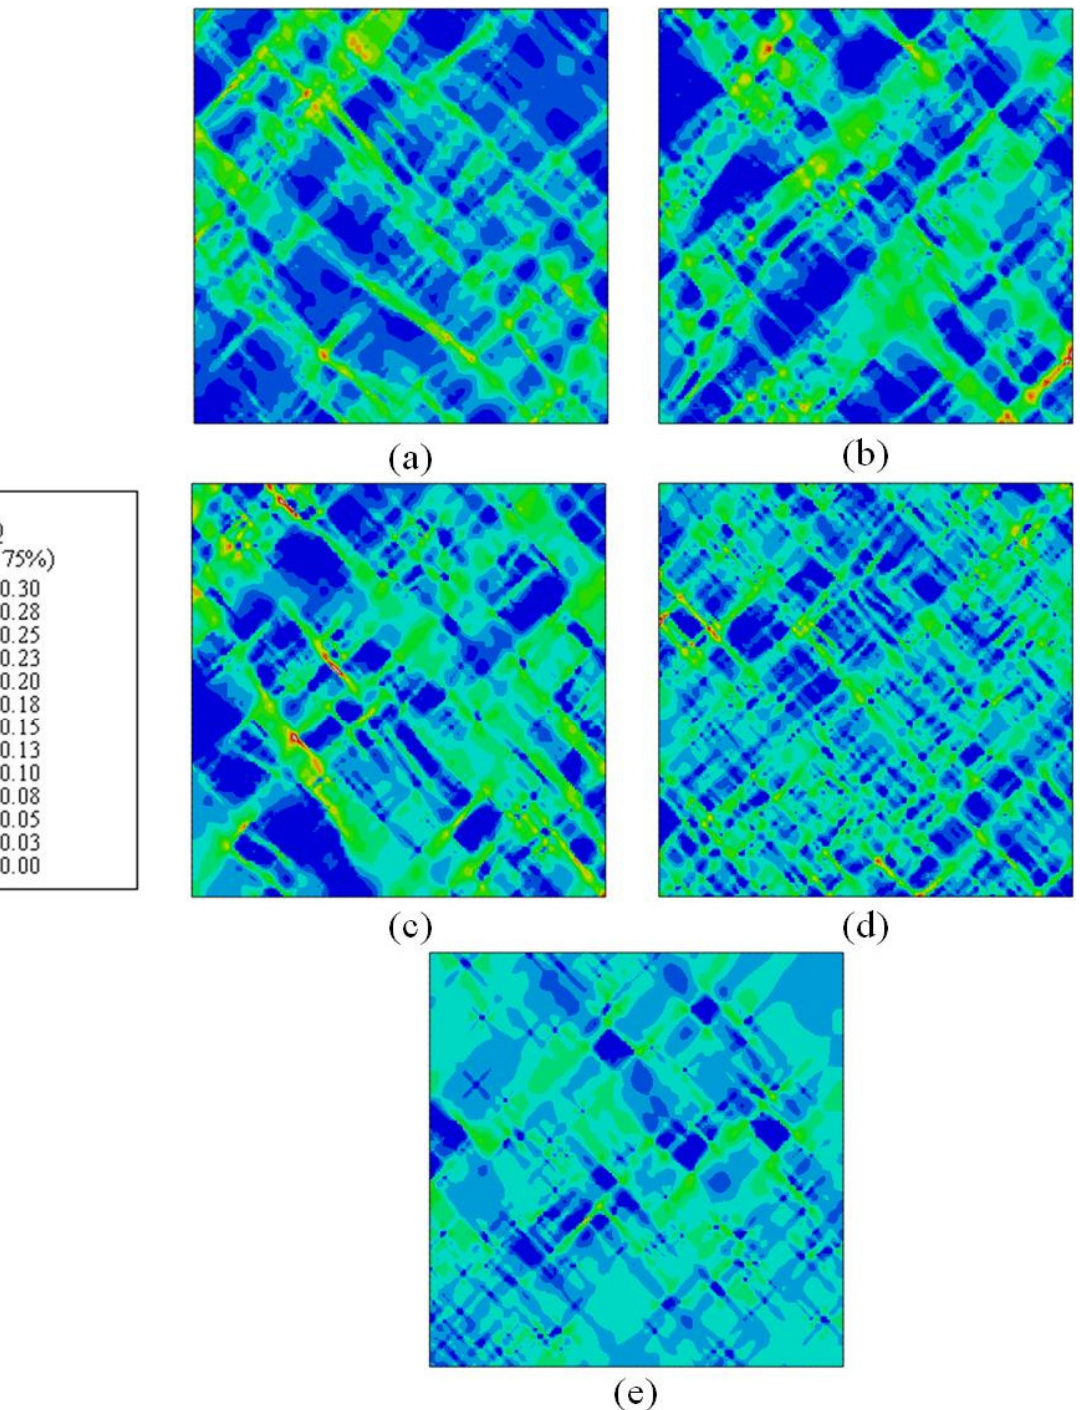
Figure 13. Predicted local distributions of equivalent plastic strain (PEEQ) at the overall strain of 7% for RVEs with varying B/M phase volume fractions ( a ) 30%B + 70%M; ( b ) 68%B + 32%M; ( c ) 80%B + 20%M; ( d ) 90%B + 10%M; ( e ) 96%B + 4%M.